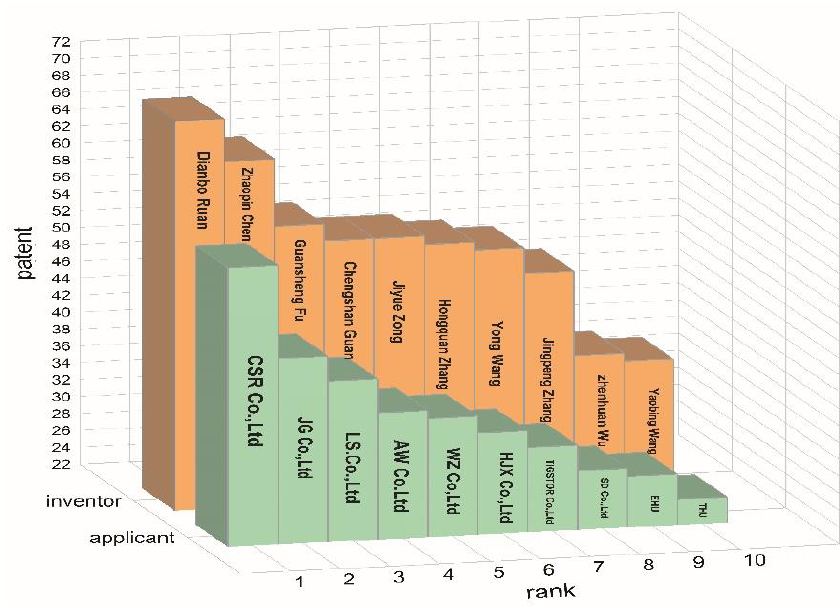
Figure 8. The top ten applicants and inventors in China.